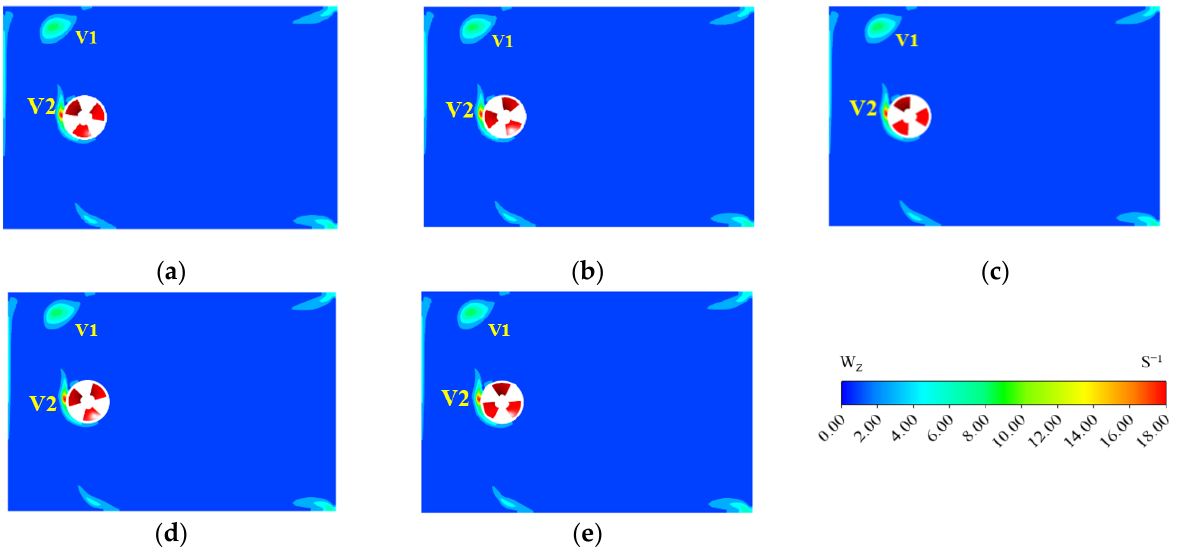
Figure 12. Vorticity field distribution near the roof at different time points. ( a ) 1/5T, ( b ) 2/5T, ( c ) 3/5T, ( d ) 4/5T, ( e ) T.